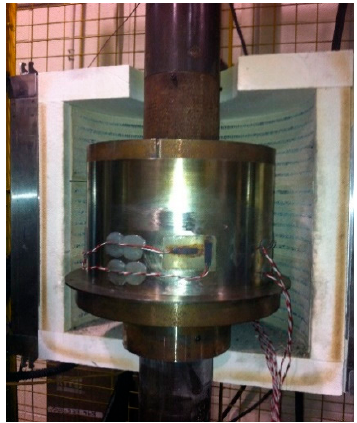
Figure 3. The experimental set-up used for compaction tests.